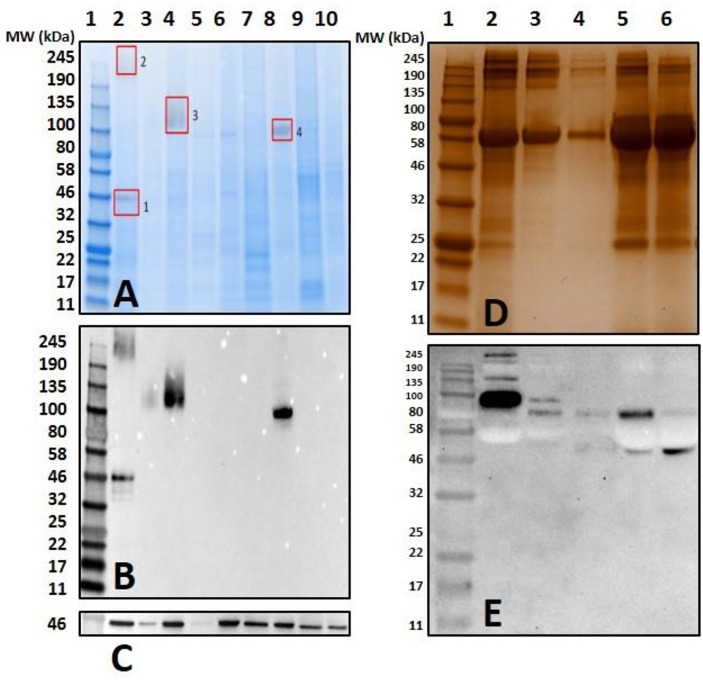
Screening salivary proteins from various ticks for the presence of α-gal and immunoproteomic workflow. Unfed and partially-fed salivary gland (SG) tissue homogenates from Ix. scapularis, Am. maculatum, Am. americanum, and De. variabilis were run using (A) an overlay of gel and blot showing excised bands for mass spectrometry analysis. Lane 1, broad range pre-stained protein standard; Lane 2, Ix. scapularis unfed SG; Lane 3, Ix. scapularis 5D partially-fed SG; Lane 4, Ix. scapularis 5D partially-fed SG; Lane 5, Am. maculatum unfed SG; Lane 6, Am. maculatum 5D partially-fed SG; Lane 7, Am. americanum unfed SG; Lane 8, Am. americanum 5D partially-fed SG; Lane 9, De. variabilis unfed SG; Lane 10, De. variabilis 5D partially-fed SG. (B) Western blot using anti-gal IgM antibody, (C) western blot probed using Beta-actin monoclonal antibody, (D) silver-stained gel of magnetic pull-down of α-gal-containing proteins using magnetic beads. Lane 1, broad range molecular weight protein standard; lane 2, “depleted” Am. americanum SG; lane 3, the α-gal pull-down product; lane 4, the magnetic beads after incubation with Am. americanum SGs; lane 5, α-gal-specific IgM after elution of α-gal; and lane 6, α-gal-specific IgM. (E) Western blotting using anti-gal antibody.